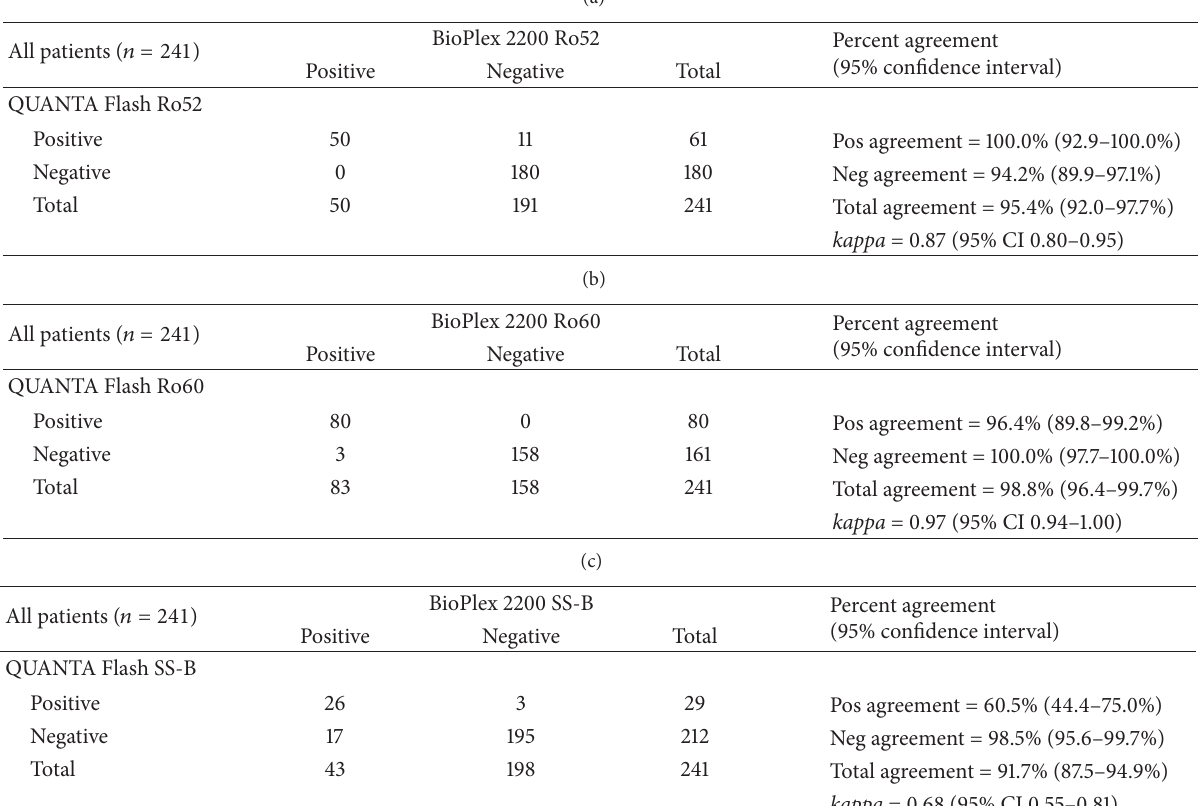
Table 2: Qualitative agreements between QUANTA Flash and BioPlex assays.